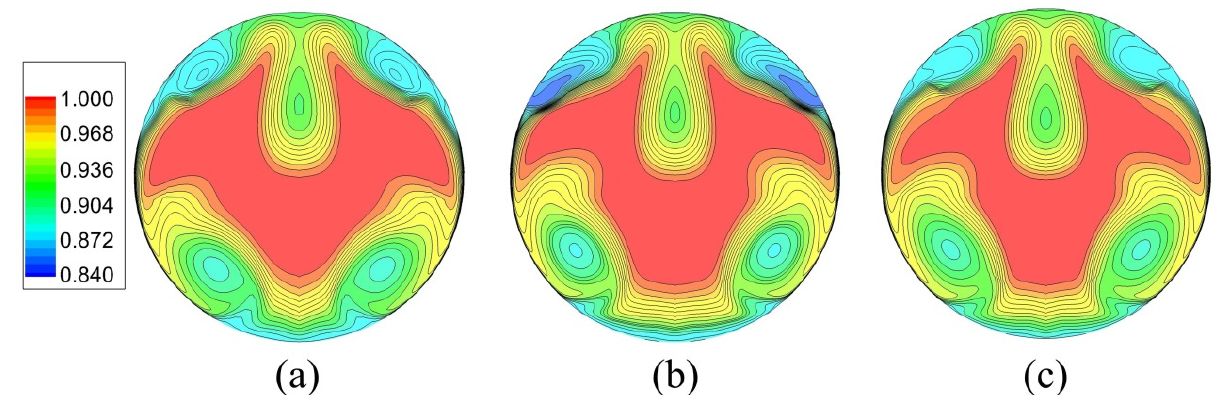
Figure 5. Comparison of the total pressure contours at the AIP calculated with different levels of mesh resolutions at M = 0.7 and p AIP / p 0 = 1.18: ( a ) Coarse grid; ( b ) Fine grid; ( c ) Dense grid.